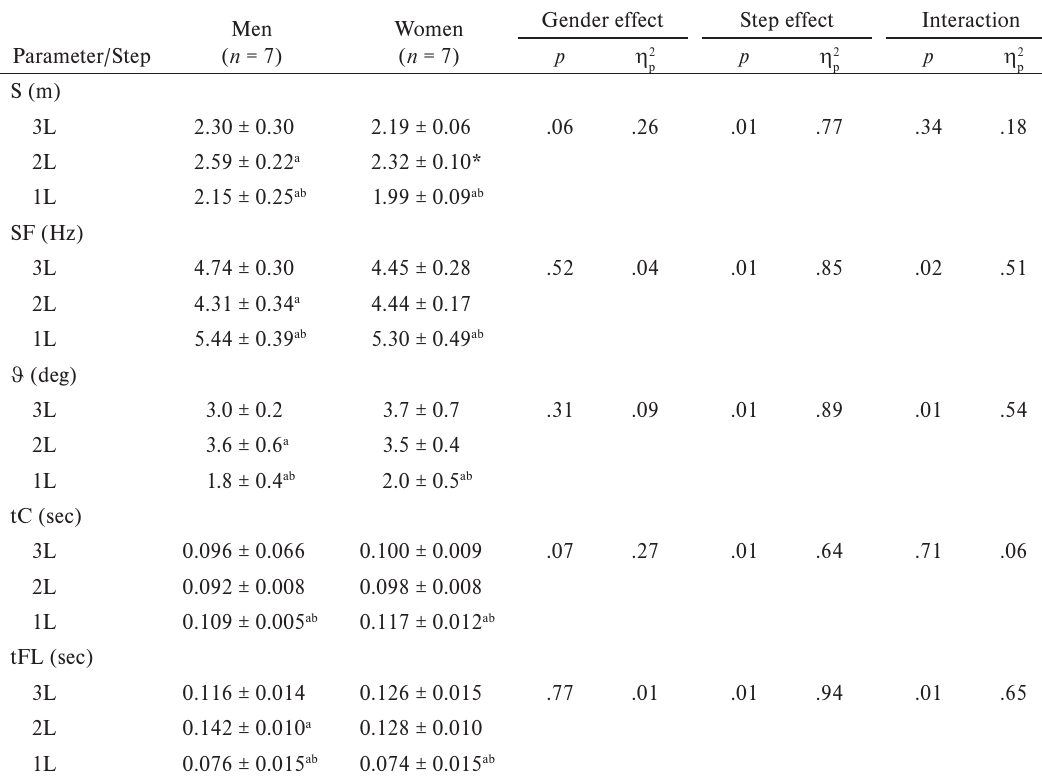
Results of the step characteristics (mean ± SD) and of the statistical testing between the examined men and women long jumpers at the final three steps of the